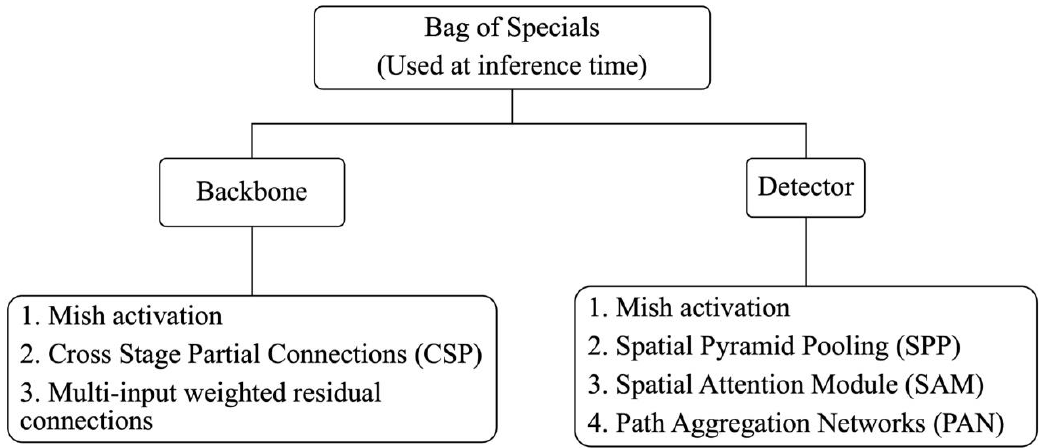
Figure 3. Different methods present in bag of specials.